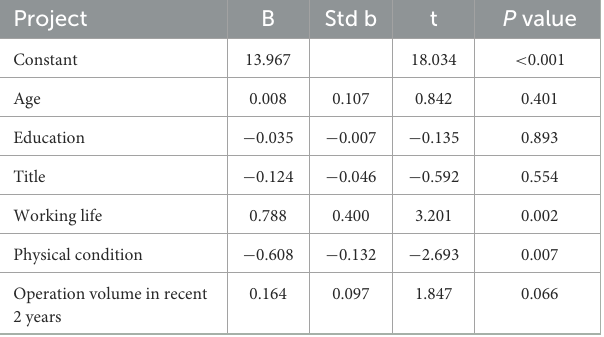
TABLE 5 Results of multiple linear regression of depersonalization.